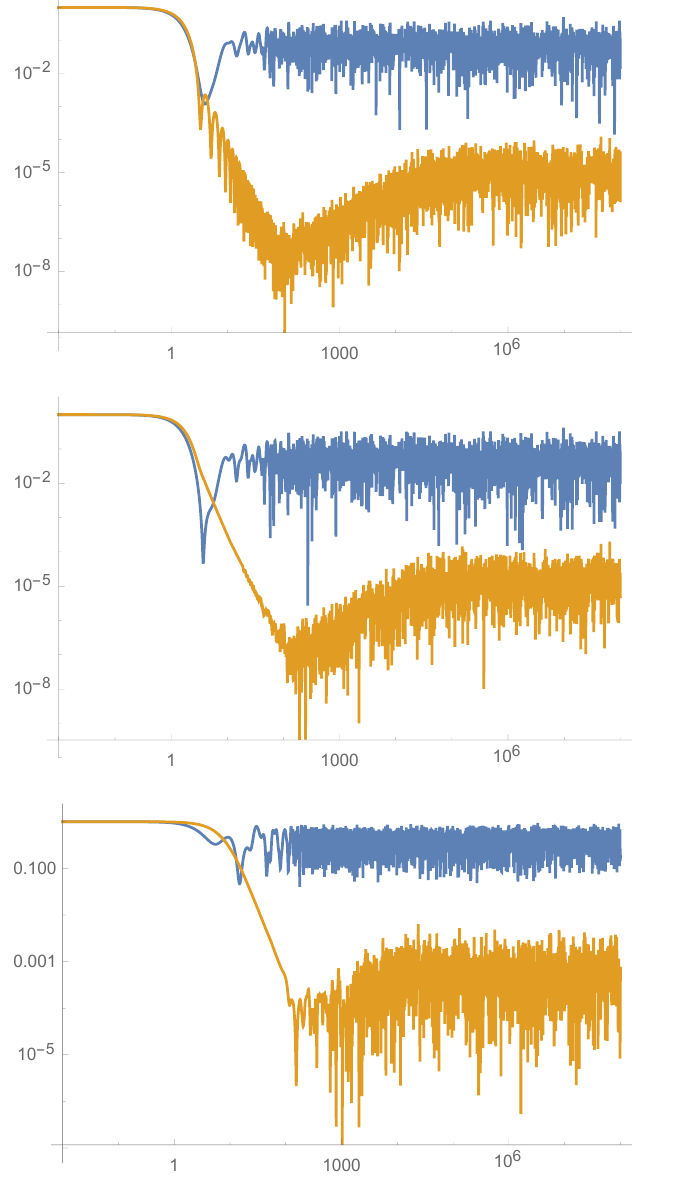
Figure 1 . The SFF for the GW model (blue color) and for SYK (yellow color). Top: (cid:12) = 0 : 1, center: (cid:12) = 1, bottom: (cid:12) = 10. The GW model is n = 2 ; D = 3, the SYK model is N =